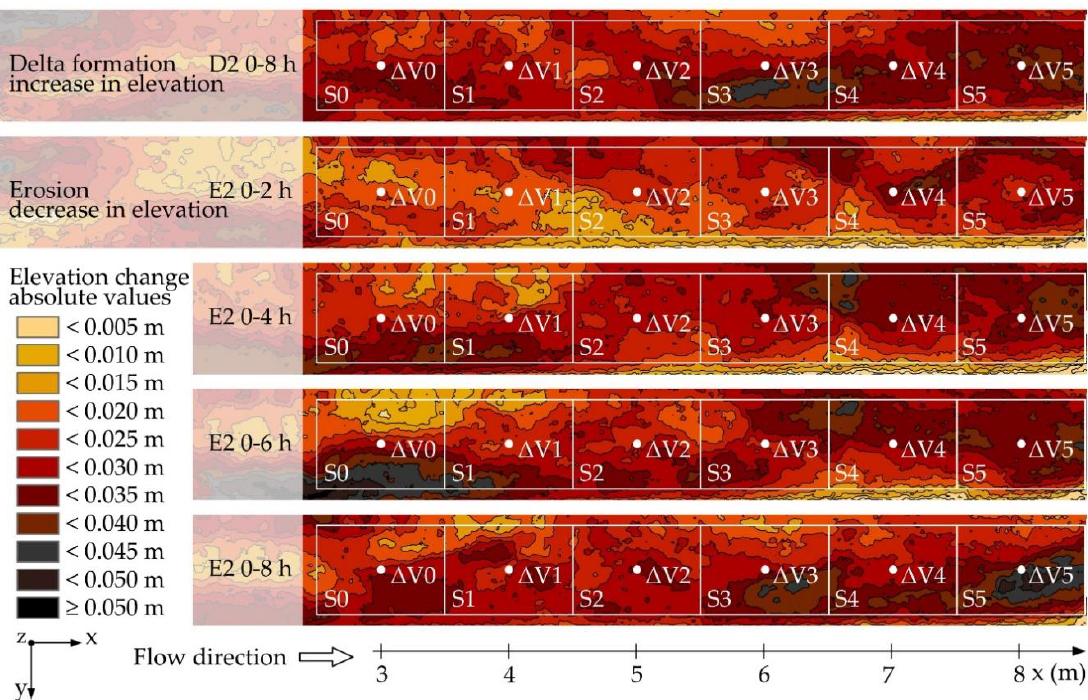
Figure A2. Volumetric analysis of the delta formation D2 and the ensuing erosion E2 during